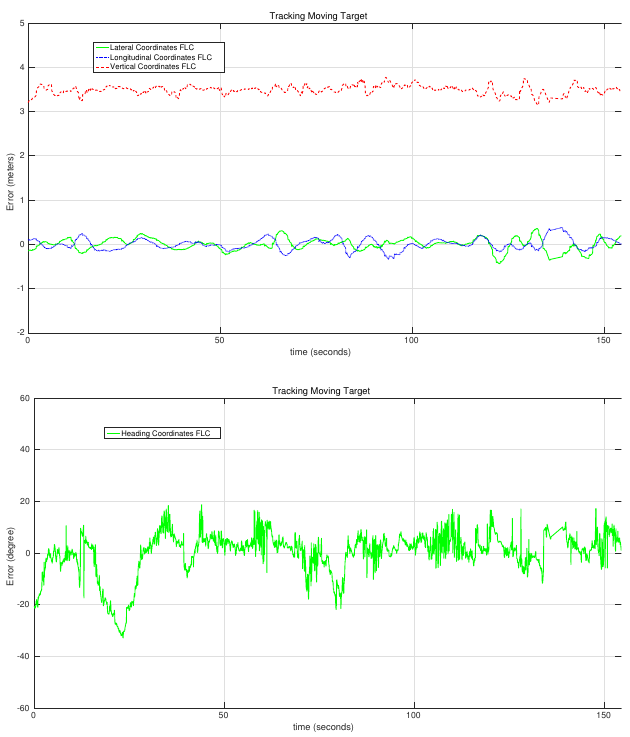
Figure 19. Evolution of the error of the lateral, longitudinal, vertical and heading controllers on the second moving target-following experiment.